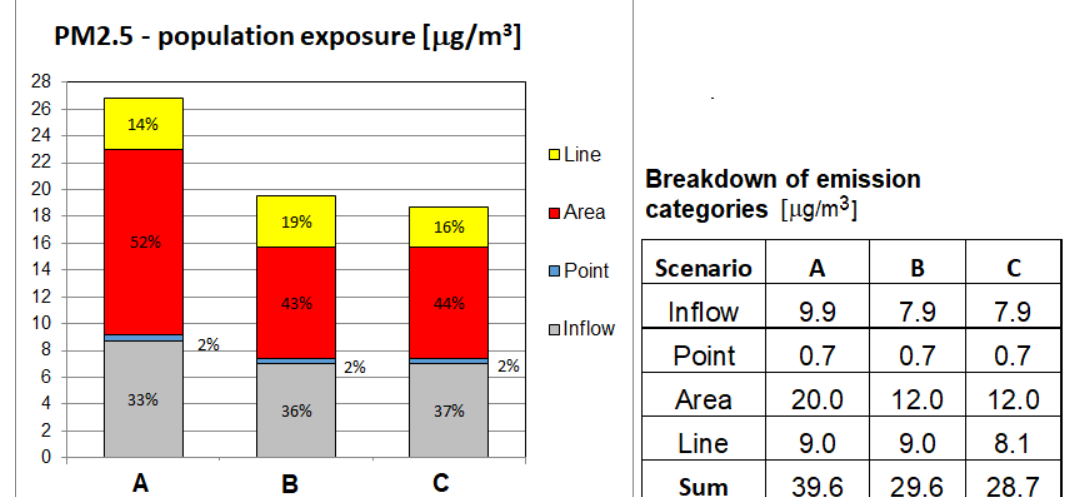
Figure 5. Modifications of PM 2 . 5 exposure.